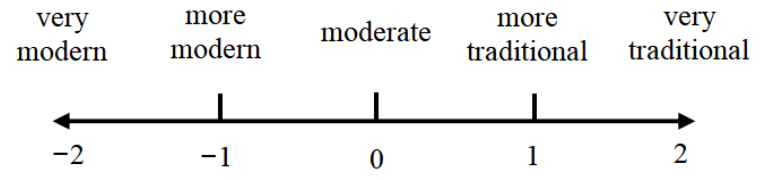
Figure 5. Semantic quantitative grading table.